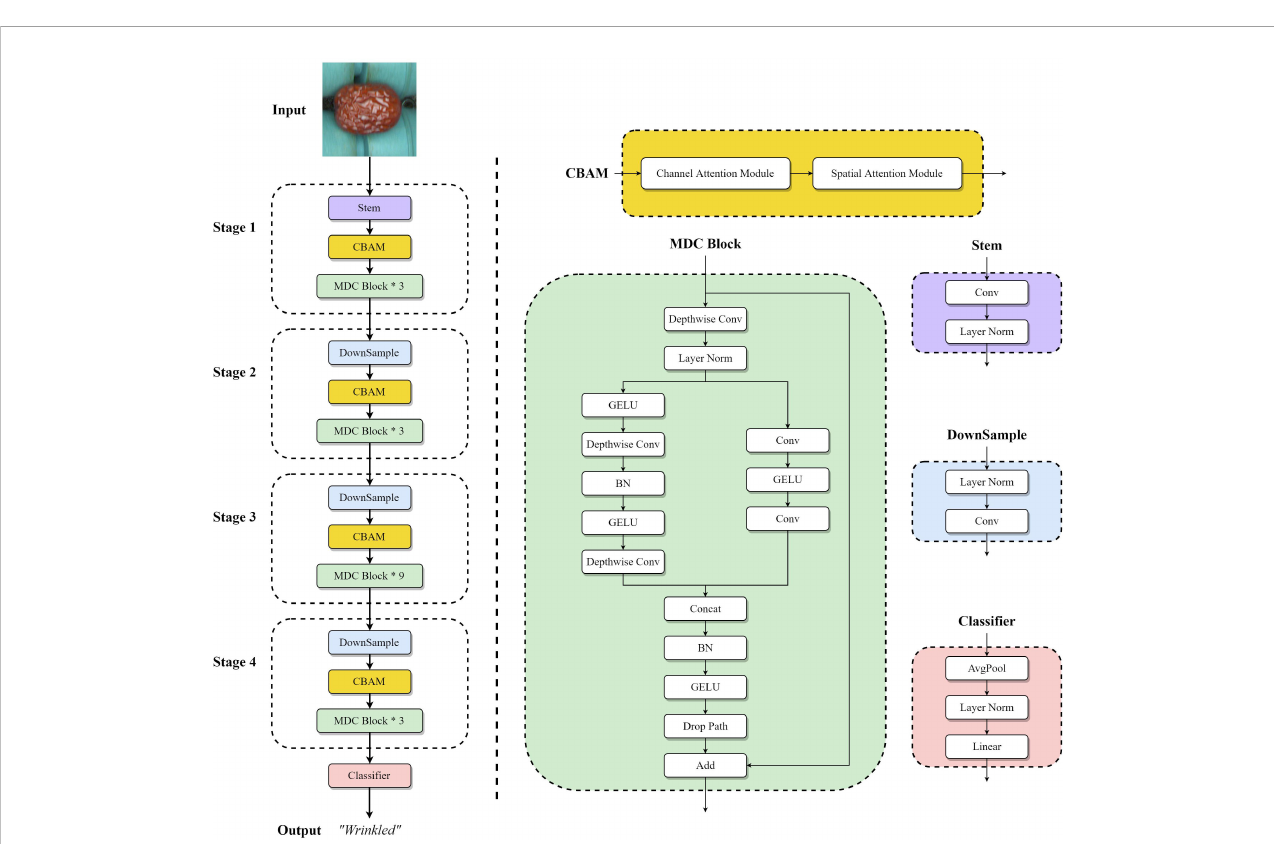
FIGURE 7 The network structure of the JujubeNet model. It consists of CBAMs (The details of the CBAM structure is shown in Section 3.5), MDC blocks, downsample modules, a stem module, and a classi fi